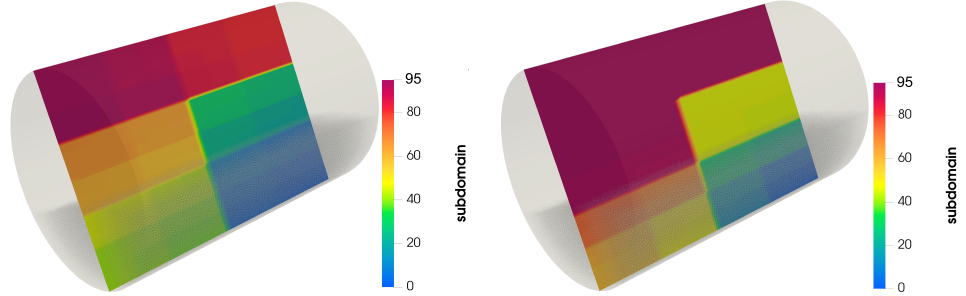
Figure 7. Distribution of particles and subdomains in the simulation of a rotating drum on 64 processes. ( left ): before load-balancing at t = 1s, and ( right ): after load-balancing at t = 8s.